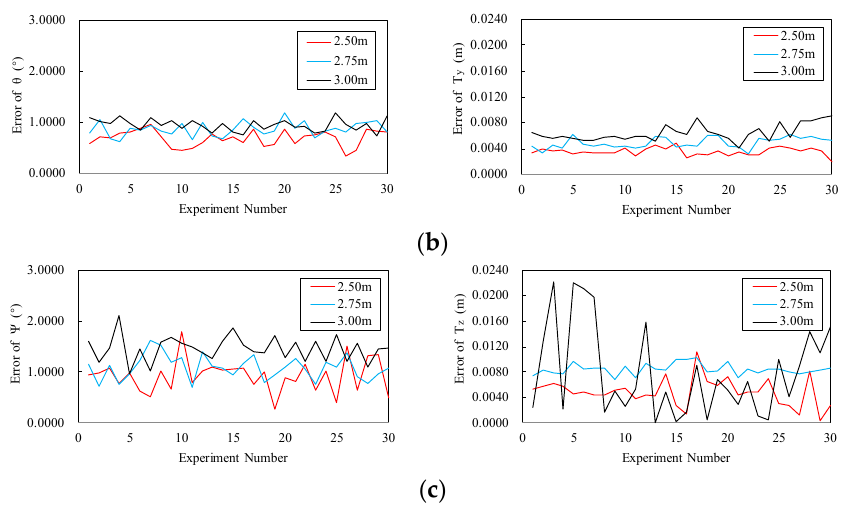
Figure 9. Comparison of measurement errors at different measurement distances: ( a ) measurement errors of the rotational DOF (left) and the movement DOF (right) along the x -axis at three measurement distances; ( b ) measurement errors of the rotational DOF (left) and the movement DOF (right) along the y -axis at three measurement distances; ( c ) measurement errors of the rotational DOF (left) and the movement DOF (right) along the z -axis at three measurement distances.